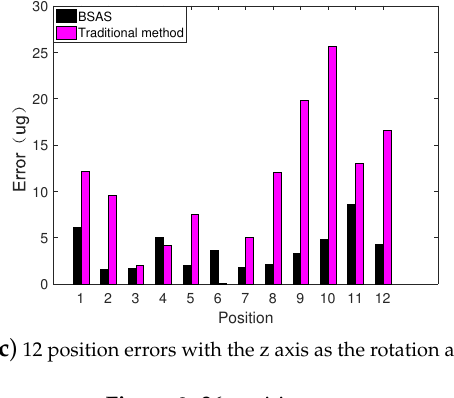
( c ) 12 position errors with the z axis as the rotation axis. Figure 9. 36 position